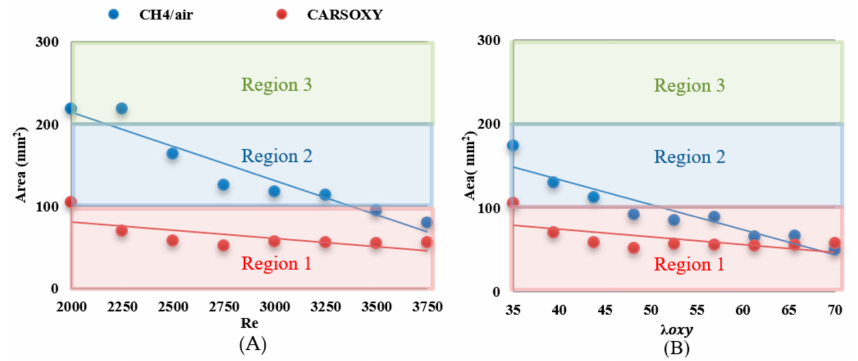
Figure 3. A of CARSOXY and CH 4 /air over ( A ) working fluid Re = [ 2000 − 3750 ] at OH Max . V CH4 = 1 L/min and ( B ) λ oxy = [ 35 − 70 ]